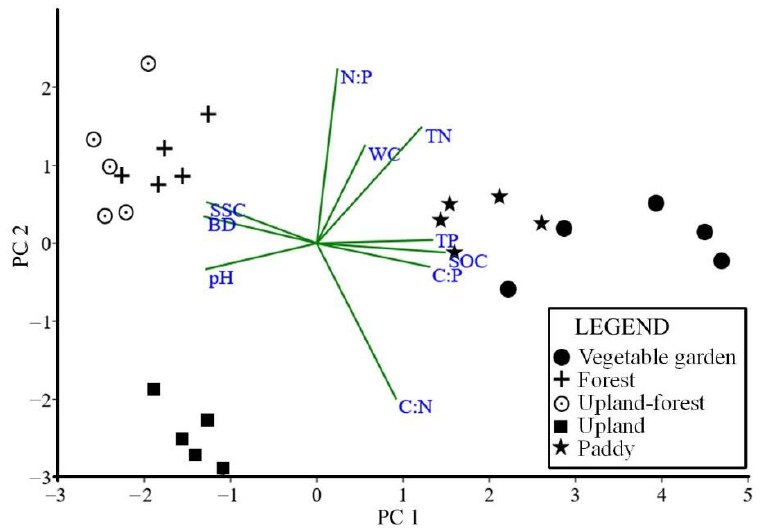
Figure 3. The PCA biplot on the determined topsoil properties.